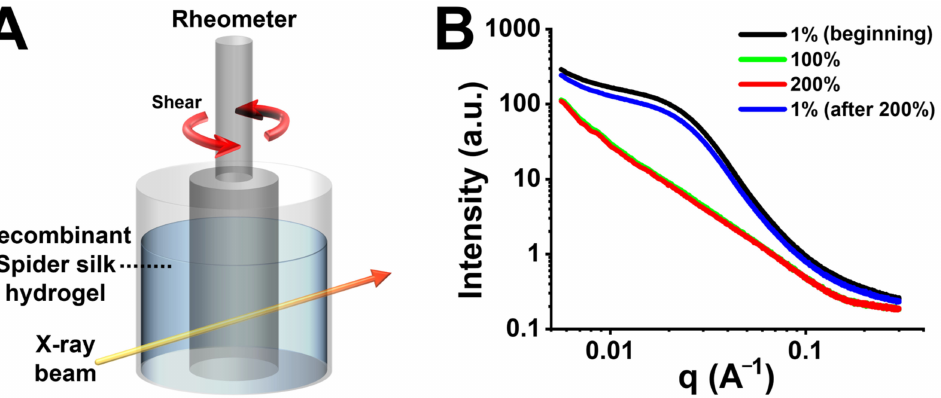
Figure 5. In situ small-angle X-ray scattering (in situ SAXS) measurements of the self-healing recombinant spider silk hydrogel at 25 ◦ C. ( A ) Schematic illustration of the experimental setup for in situ SAXS measurements. ( B ) The small-angle X-ray scattering (SAXS) profiles of the recombinant spider silk hydrogel under different strains [i.e., 1% (beginning), 100%, 200%, and 1% (after